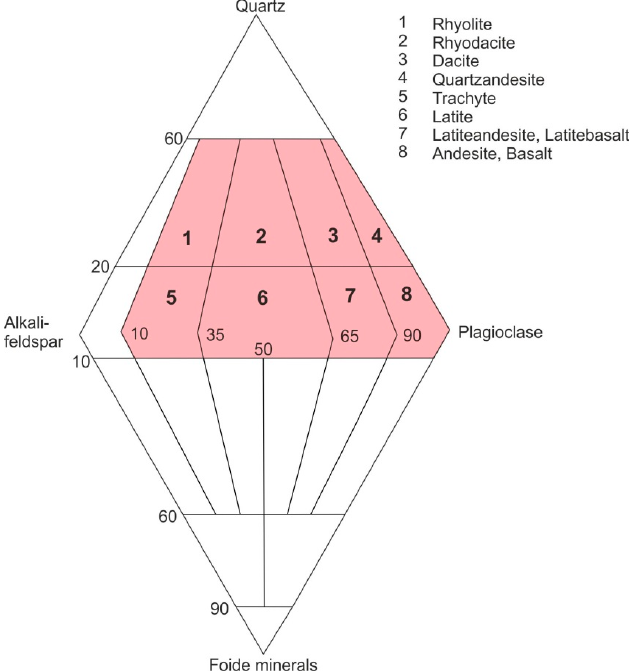
Figure 1. Streckeisen diagram showing the field ( red ) of agate ‐ bearing volcanic rocks.